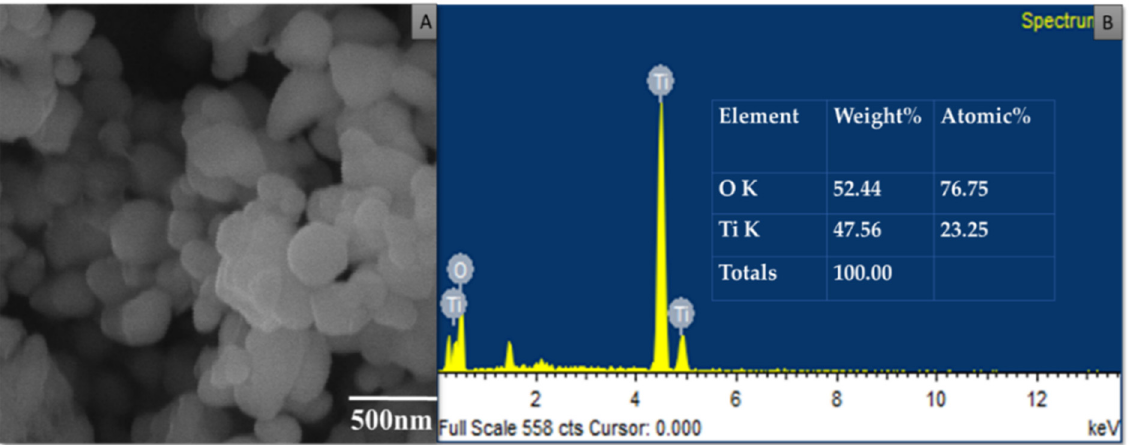
Figure 5. SEM/EDX of TiO 2 nanoparticles. ( A ) SEM image of TiO 2 nanoparticles at 500 nm. ( B ) EDX of TiO 2 nanoparticles.